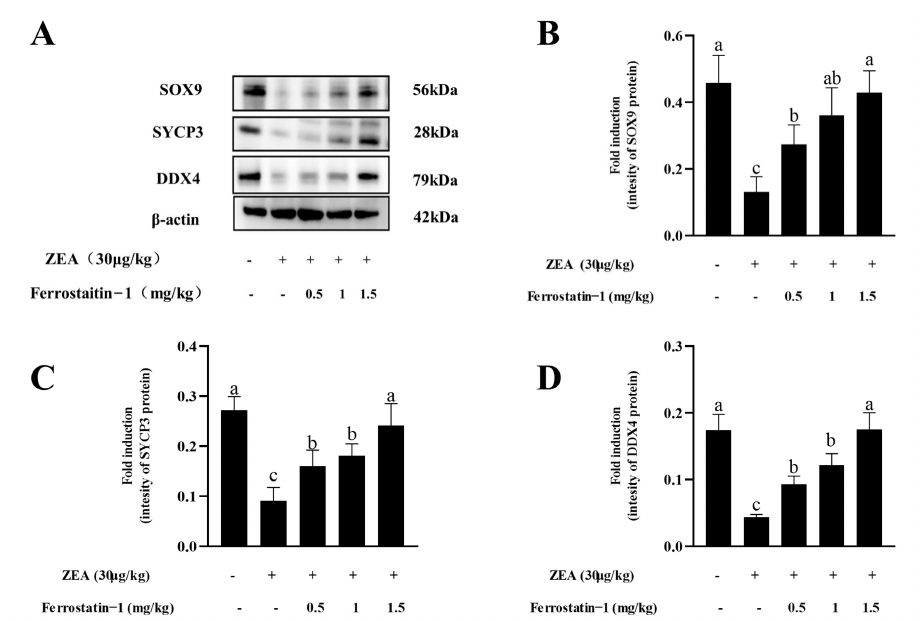
Figure 3. Expressions of SOX9, SYCP3, and DDX4 in the testis of mice in each group. ( A ) Western blot detection of SOX9, SYCP3 and DDX4 protein. ( B ) Image J analysis showing the grey value of SOX9. ( C ) Image J analysis showing the grey value of SYCP3. ( D ) Image J analysis showing the grey value of DDX4. The data are expressed as means ± SEM, with n ≥ 3; Different lowercase letters (a, b, c) indicate significant differences ( p < 0.05).